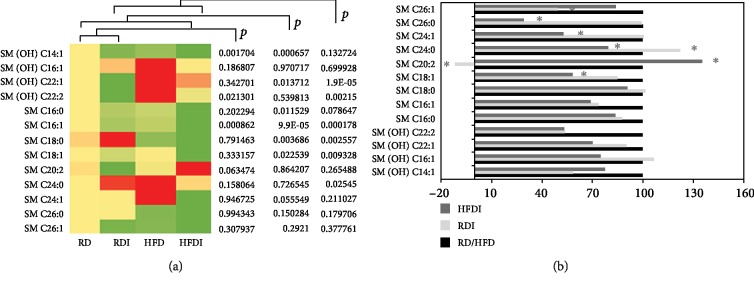
Comparison of sphingolipid profiling between T. cruzi-infected and uninfected mice fed on different diets at 150 DPI. (a) Heat map representing the serum levels of various sphingolipids during chronic infection in mice fed on either a RD or a HFD compared to uninfected RD mice at 135 DPI. Each row represents data for a specific metabolite, and each column represents the RD-fed uninfected (RD), RD-fed infected (RDI), HFD-fed uninfected (HFD), or HFD-fed infected (HFDI) mouse group. Different colors correspond to the different intensity level of metabolites (red > the control RD group and green < the control RD group). Statistically significant differences were tested using Student's t-test, and the corrected p values (q-value) are presented next to the heat map. Red, yellow, and green rectangles indicate high, moderate, and low expressions, respectively. (b) The percentage changes in the levels of sphingolipid metabolites in infected mice compared to the respective diet-fed (RD and HFD) uninfected mice represented by a bar graph (∗significant change).